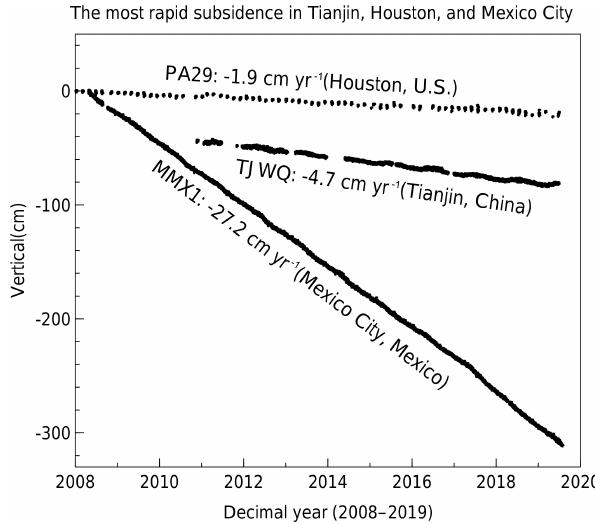
Figure 4. Comparisons of the most rapid ongoing subsidence recorded by GPS in Tianjin (China), Houston (US), and Mexico City (Mexico).